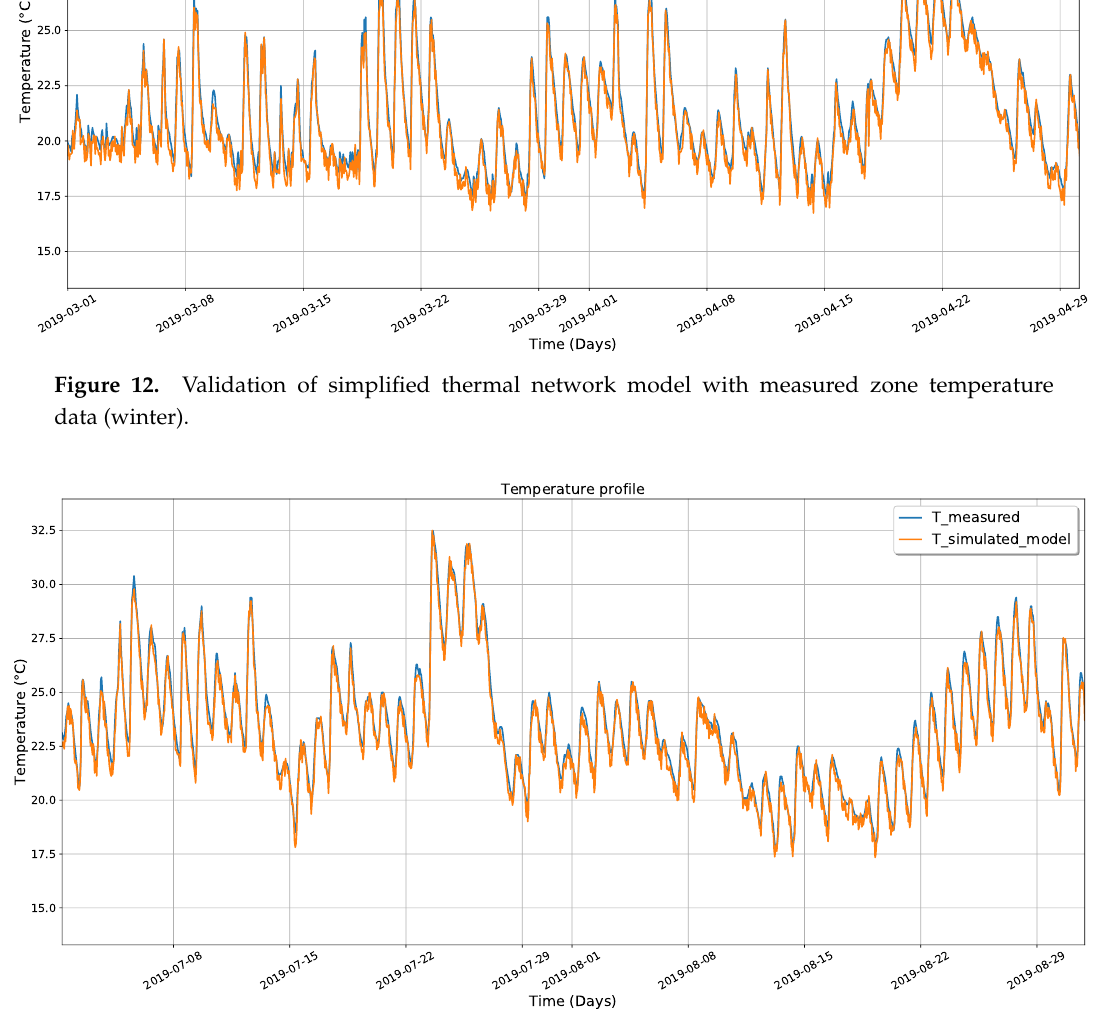
Figure 13. Validation of simplified thermal network model with measured zone temperature data